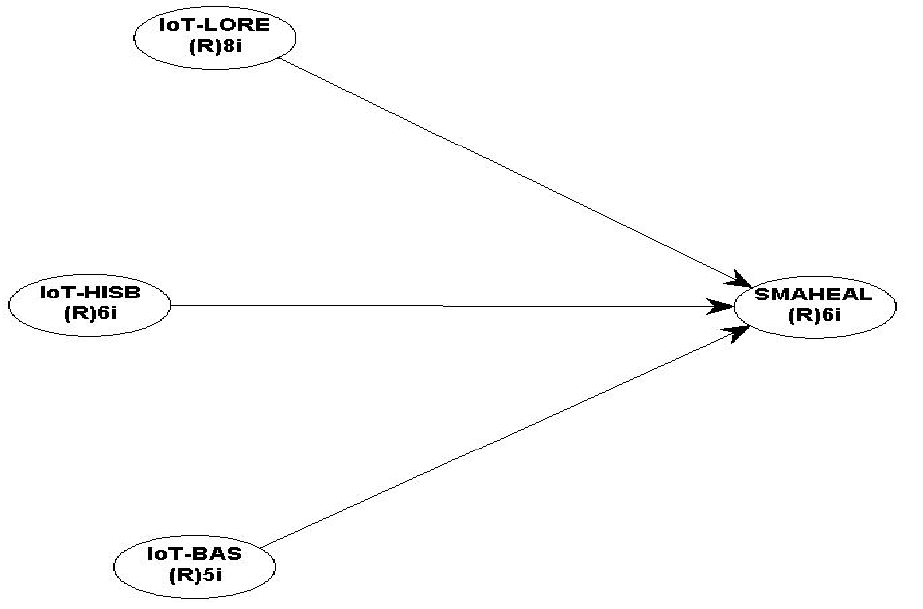
Figure 2. Measurement model.